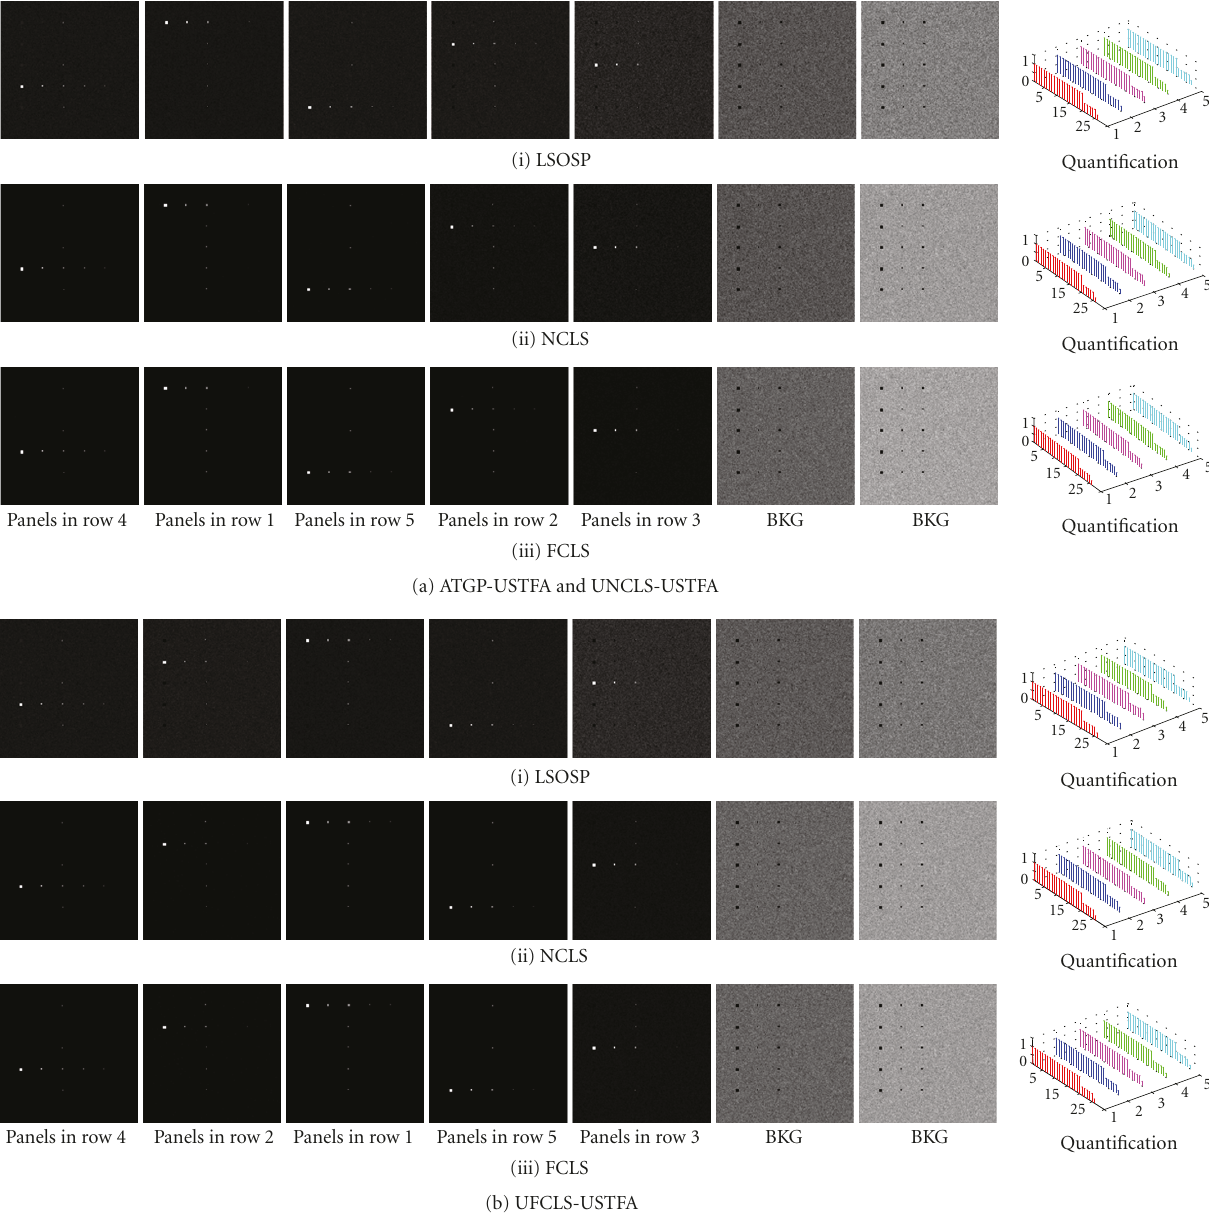
Figure 11: Results of using LSOSP, NCLS, and FCLS to unmix TI via the target pixels found in Figure 4(d).